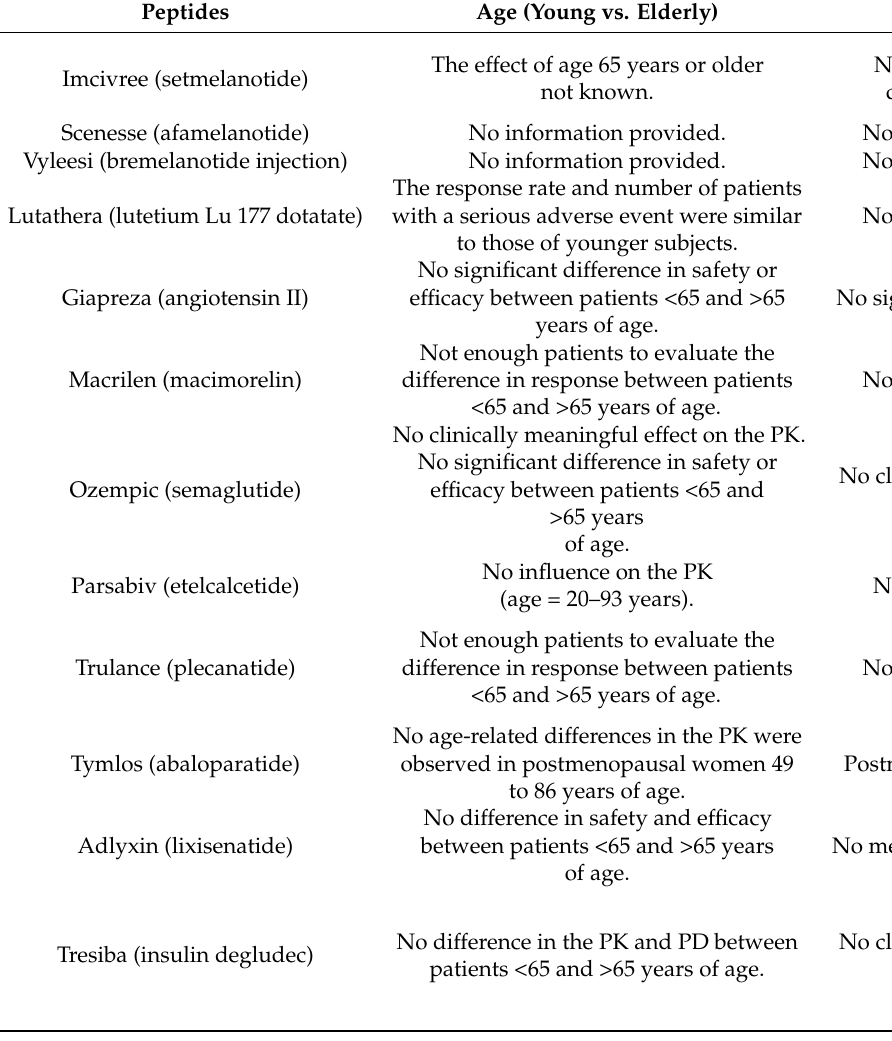
Table 2. Impact of age, sex, and race on the pharmacokinetics of peptides.